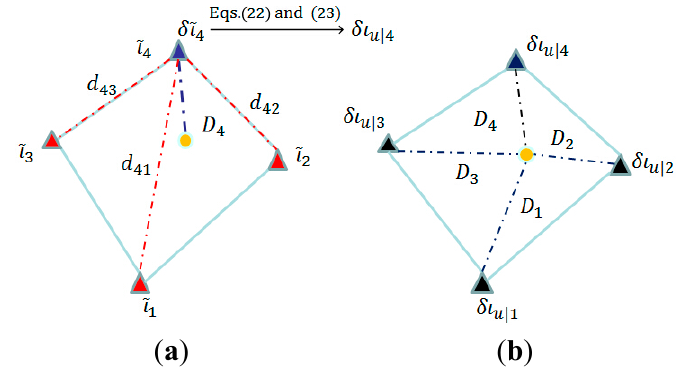
Figure 1. Atmospheric stochastic model estimated with the observations of a reference network. ( a ) determination of interpolated ionospheric errors at selected reference stations; ( b ) determination of variance for interpolated ionospheric error at user stations.